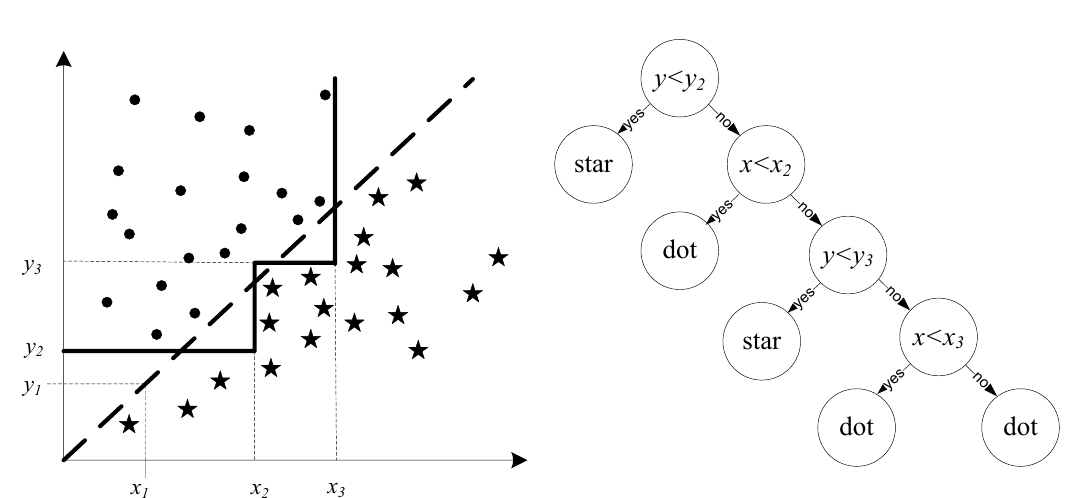
Figure 2. (left) Two class recognition problem and liner classifi er boundary (dashed line) and univariate decision tree classifi er boundary (solid line); (right) univariate decision tree structure for the problem presented in the left